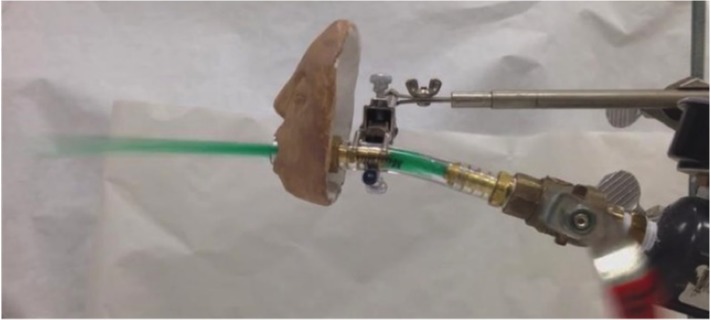
Photo of a Simulated Vomiting Episode.Projectile vomiting of colored simulated vomitus matrix.